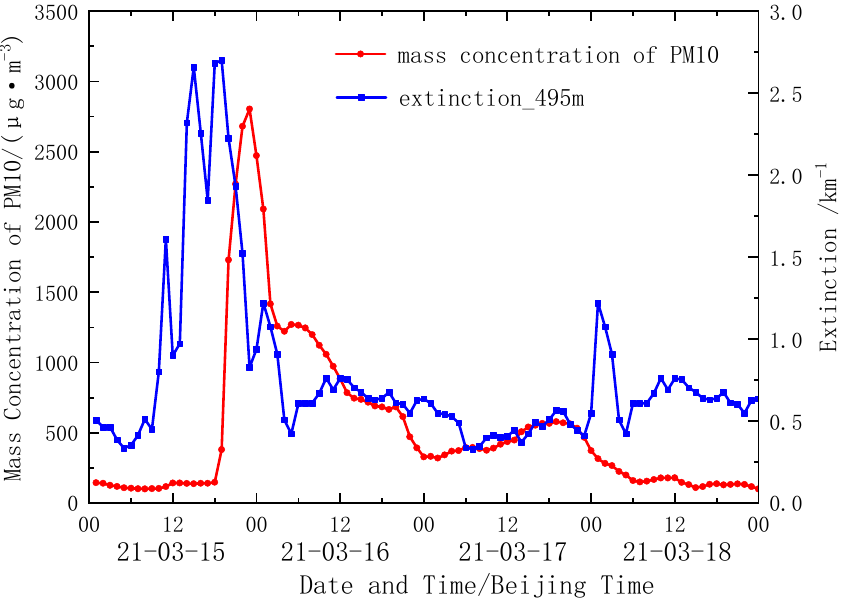
Figure 6. Time distribution of the extinction coefficient at 495 m and the mass concentration of PM10 on the surface.